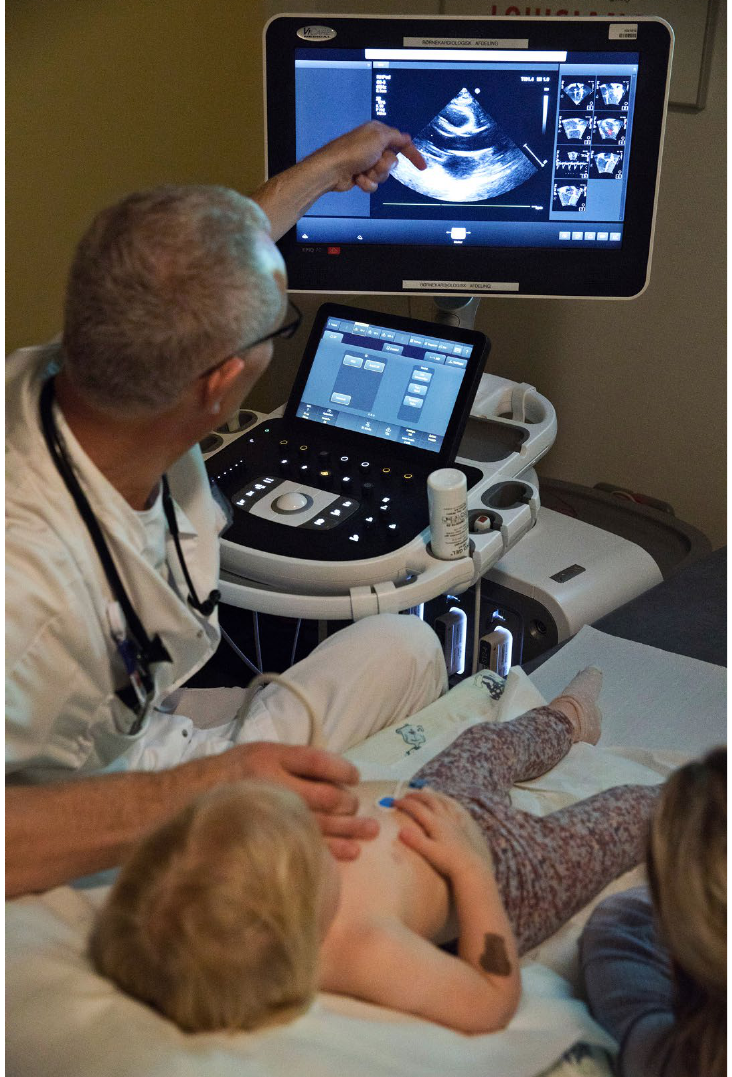
Figure 1. Echocardiography in an outpatient clinic. Photo by Sine Fiig for the Danish Heart Foundation for the book Medfødte Hjertefejl from 2017. (Permission for reuse given by the